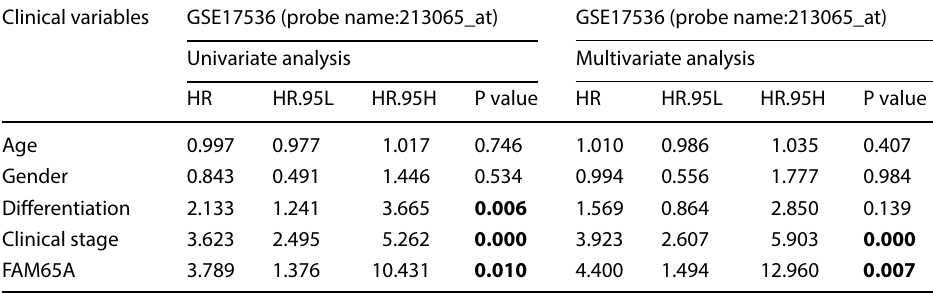
Table 1 Univariate and multivariate cox analysis of clinical characteristics for COAD patients in GSE17536 cohort